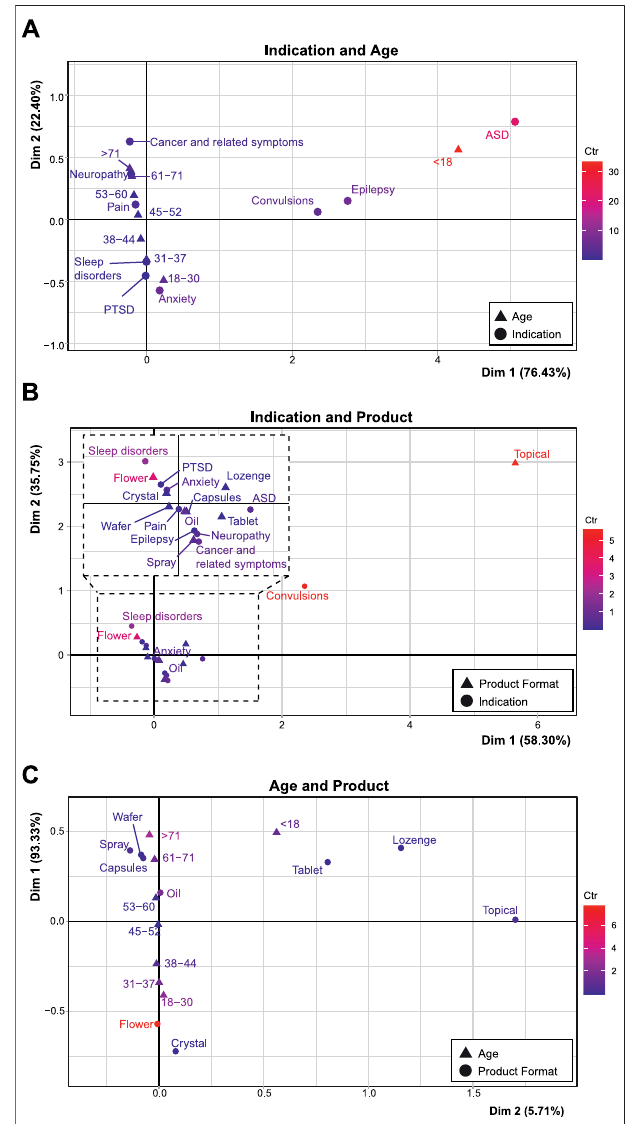
FIGURE 7 | Associations between age, product format, and indication. Correspondence analyses with groups of age compared with indication (A) , indication compared with product preference (with an inset representing an expandedviewofthedashed area; (B) ,andage compared withproduct preference (C) .Descriptionofdeviationfromindependenceislabelledwiththe according axes, while the red to blue color gradient indicates the scaled contribution of these factors to the overall variance (the inertia*100; “ Ctr ” ) for eachgraph.Themaximuminertia*100are33.07,8.47,and5.56,respectively. See SupplementaryTablesS3 – S5 forthecontributionofvariancerelatedto these